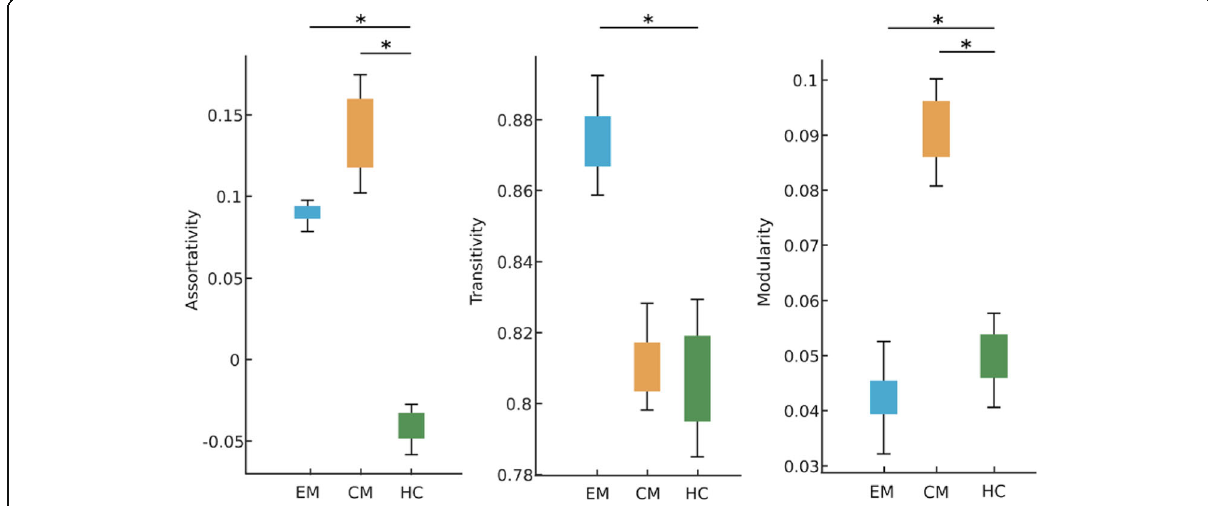
Fig. 2 Cortical network results: Plots showing the network measures (assortativity, transitivity and modularity) significantly different between the groups: episodic migraine patients (EM), chronic migraine patients (CM) and healthy controls (HC) obtained using CT. * indicates significant group differences at p < 0.05 (FDR